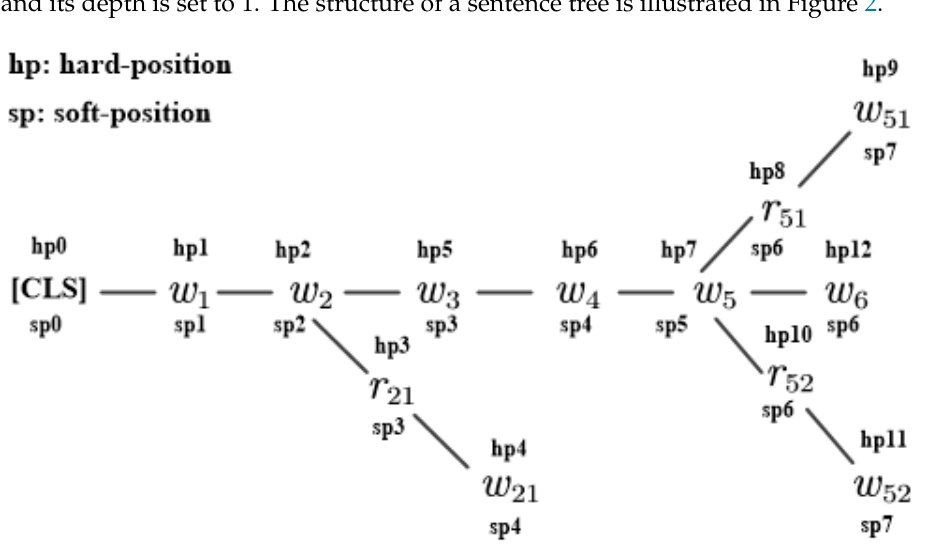
Figure 2. Structure of a sentence tree. The tree starts with [CLS] and is extended in the order of the words. Each branch is a triple that is queried.